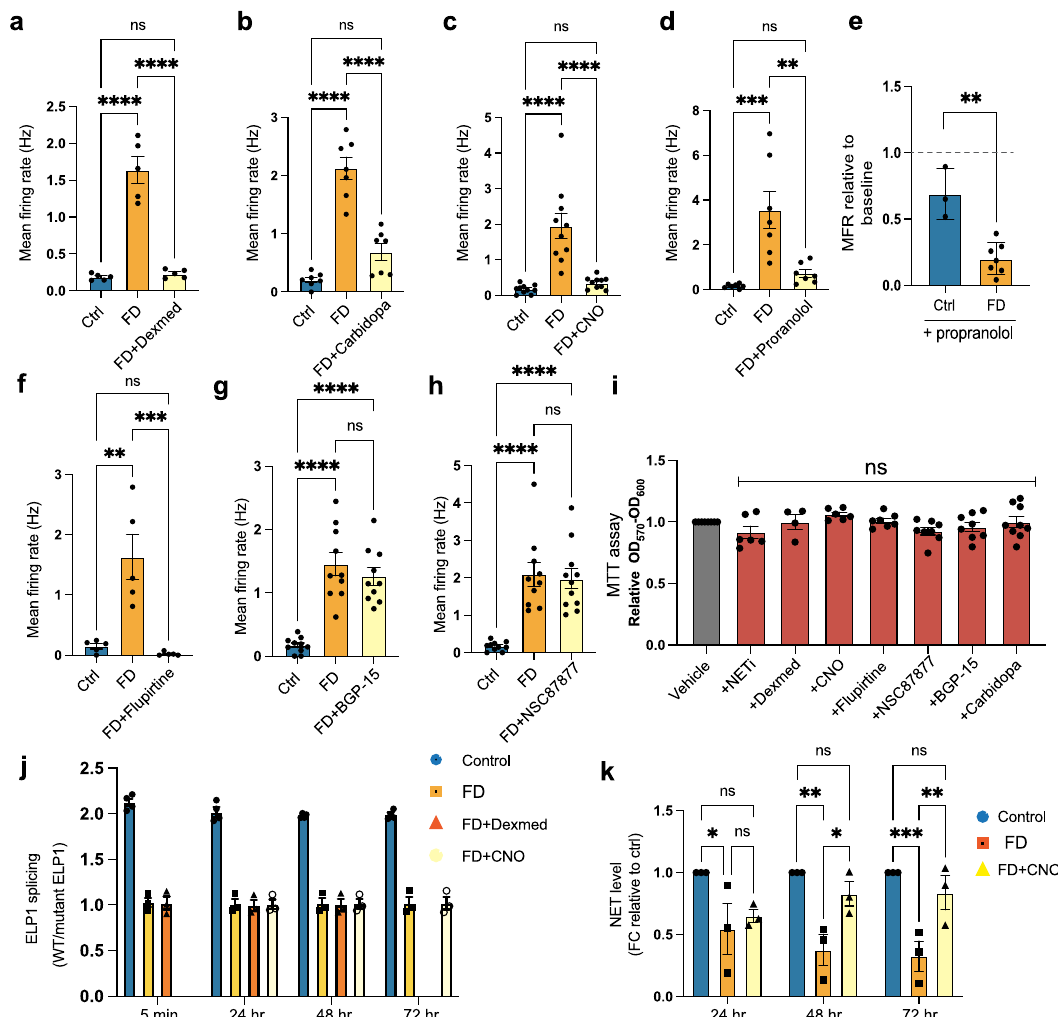
Fig.5|MinidrugscreentorescuesympatheticneuronhyperactivityinFamilial Dysautonomia. A selection of drugsare added to FD symN onday35,followedby MEA measurements. The dosage and treating conditions of each are: a Dexmed (60 μ M) for 5min. N =5 biological replicates. One-wayANOVA followed by Tukey ’ s multiple comparisons. Error bar represents the SEM. **** P <0.0001. b Carbidopa (25 μ M) for 5min. N =7 biological replicates. One-way ANOVA followed by Tukey ’ s multiple comparisons. Error bar represents the SEM. **** P <0.0001. c Clozapine (CNO, 3 μ M) for up to 72h in order to stimulate NET expression. N =10 biological replicates. One-way ANOVA followed by Tukey ’ s multiple comparisons. Error bar represents the SEM. **** P <0.0001. d Propranolol (1 μ M) for 5min. N =7 biological replicates. One-way ANOVA followed by Tukey ’ s multiple comparisons. Error